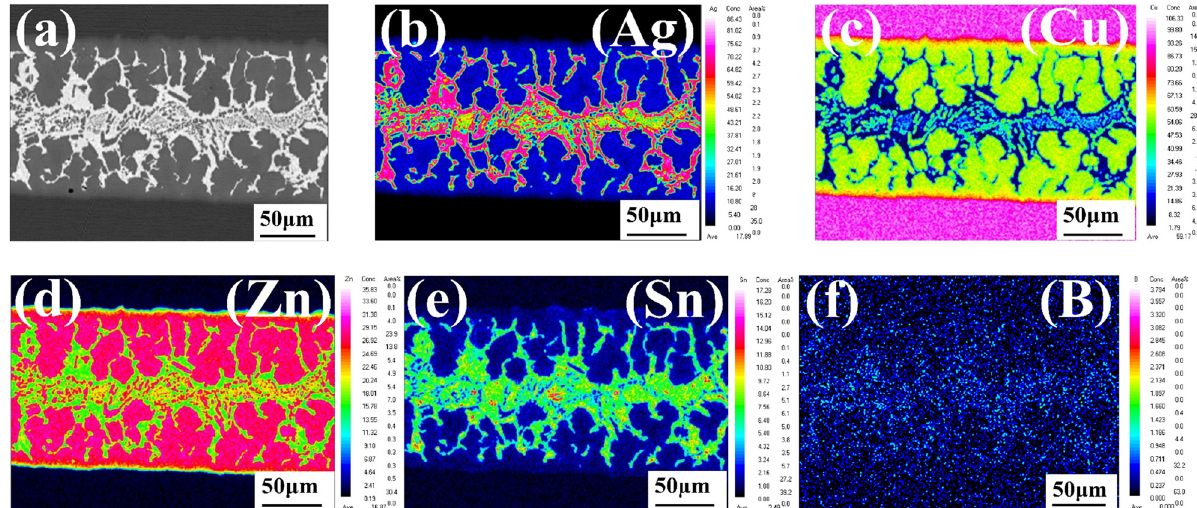
Figure 5: Surface scan distribution of the joint with 3% B. ( a ) Cross - sectional morphologies of the joint, ( b ) Ag, ( c ) Cu, ( d ) Zn, ( e ) Sn, and ( f )